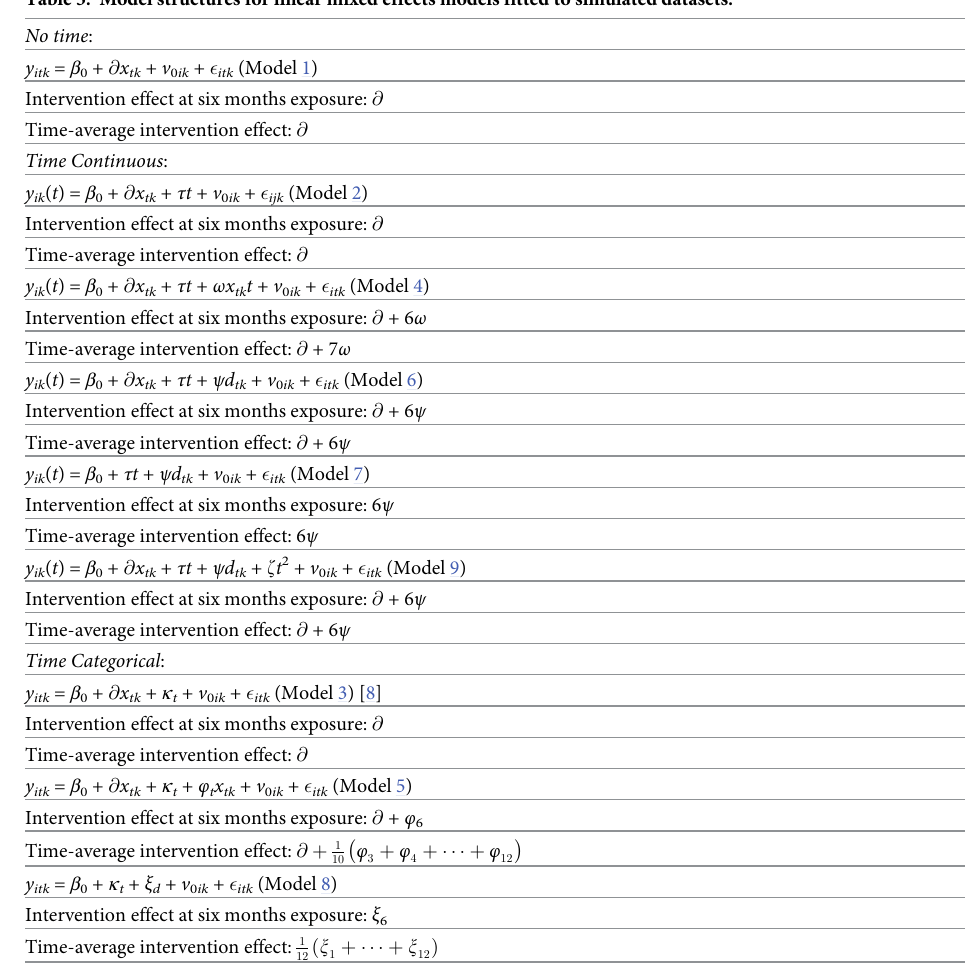
Table 3. Model structures for linear mixed effects models fitted to simulated